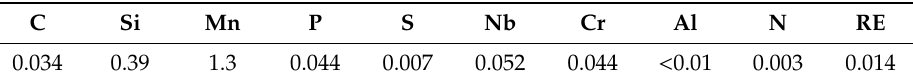
Table 1. Chemical composition of investigated alloys in mass fraction